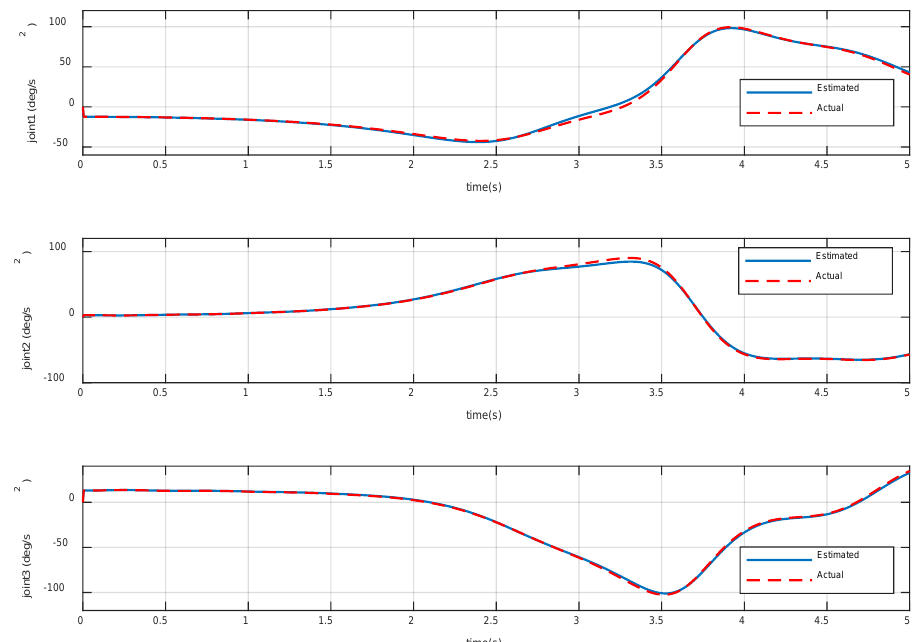
Figure 8. Variation of joint accelerations.